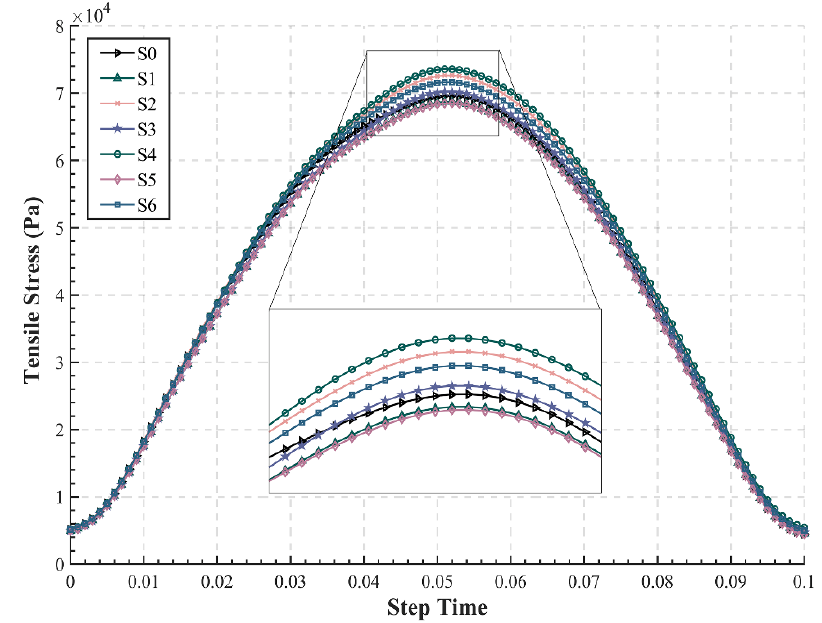
Figure 6. Time–history curve of tensile stress at the bottom of the base